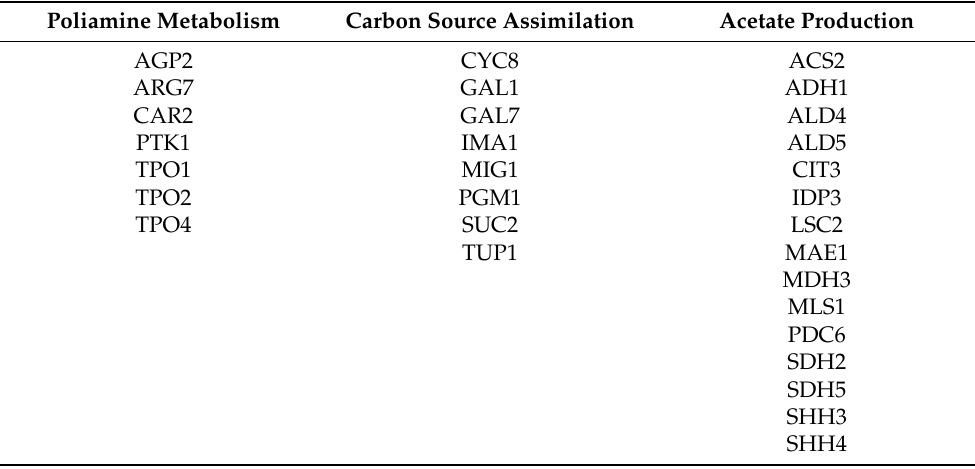
Table 2. Genes predicted to be associated with the main probiotic properties of S. cerevisiae var. boulardii (data acc. to Pais et al.